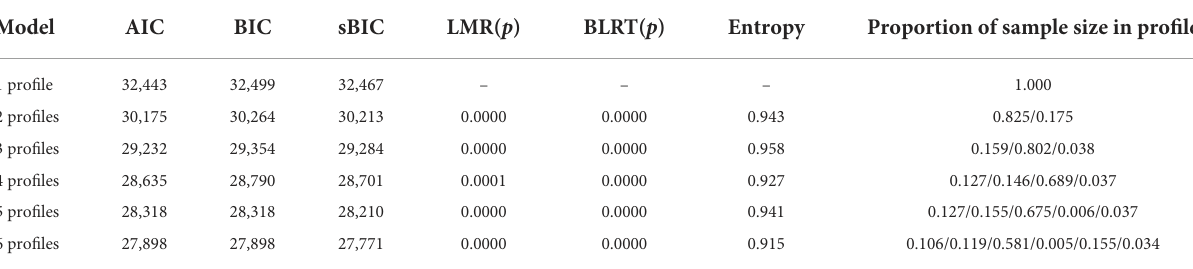
TABLE 3 Fit statistics for profile